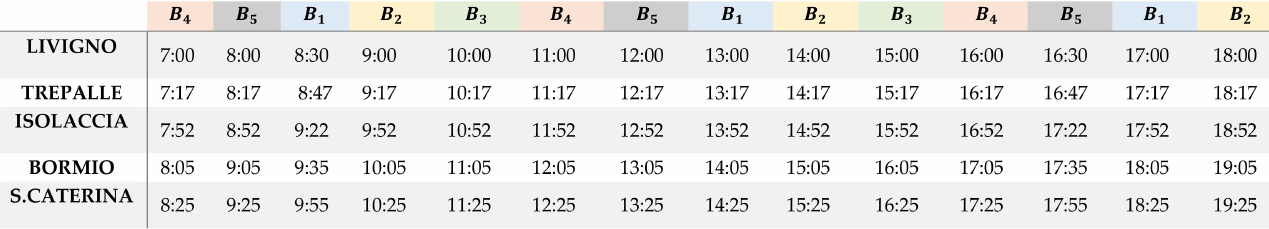
Figure 11. High season Backward.